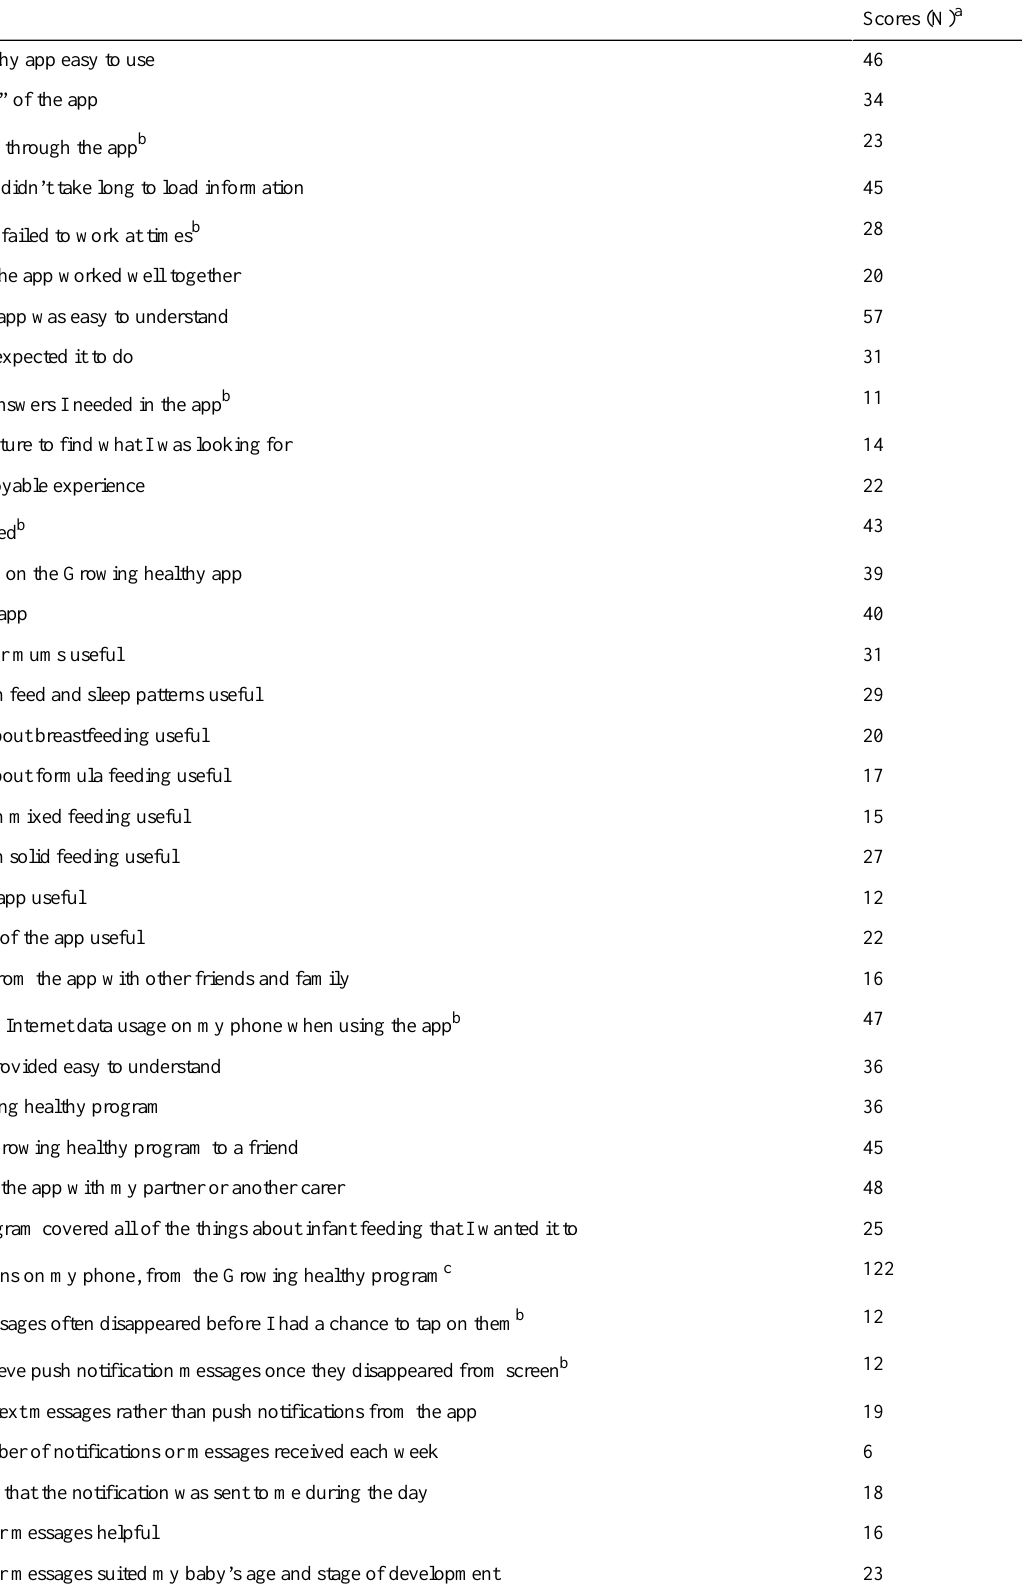
Scores (N) a Satisfaction